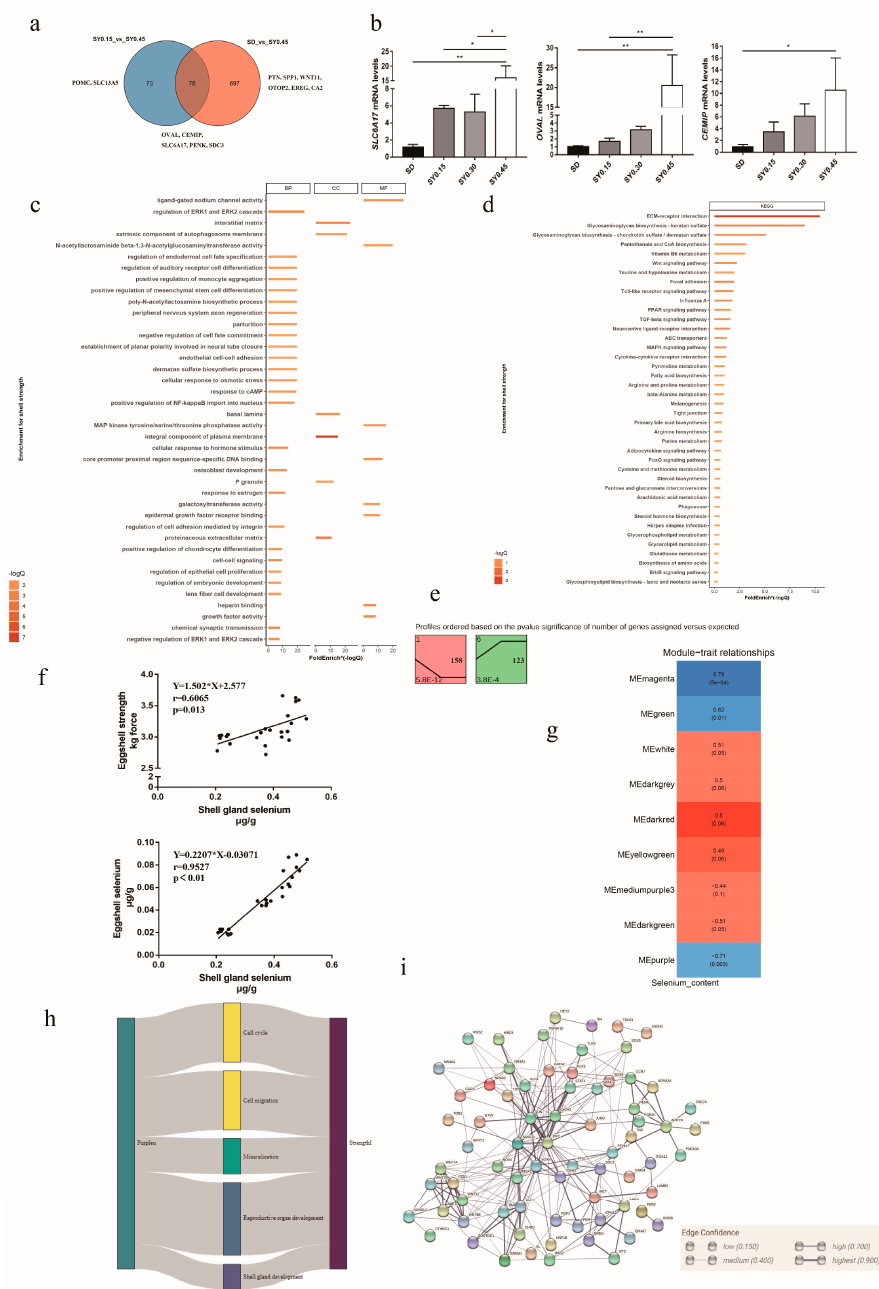
Figure 3. The potential molecular mechanism of selenium yeast affecting the eggshell strength in aged laying hens. ( a ) Venn diagram showing the distribution of DEGs associated with eggshell strength. ( b ) Validation of DEGs associated with eggshell strength using qRT-PCR, * means p < 0.05 and ** means p < 0.01. ( c ) Gene Oncology enrichment analysis of DEGs associated with eggshell strength (SY0.15 vs. SY0.45 and SD vs. SY0.45). ( d ) KEGG pathway enrichment analysis of DEGs associated with eggshell strength (SY0.15 vs. SY0.45 and SD vs. SY0.45). ( e ) Trend analysis of DEGs associated with eggshell strength expression. Colored block trend: significant enrichment trend ( p < 0.05). ( f ) The linear correlation between shell gland selenium content with eggshell strength and eggshell selenium content. ( g ) WGCNA analysis identified specific transcriptional modules related to eggshell strength in aged laying hens after selenium yeast supplementation. ( h ) Sankey charts were performed among differential expressed genes in modules and pathways. ( i ) The PPI network of common genes in modules and